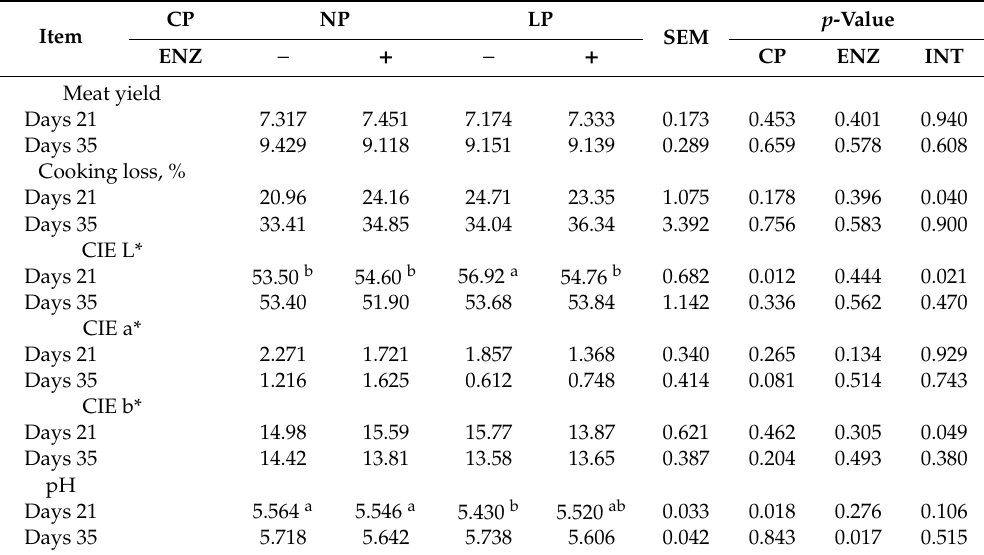
Table 5. E ff ects of low-protein diet and exogenous protease on breast meat yield (g / 100 g of live body weight) and meat quality in broiler